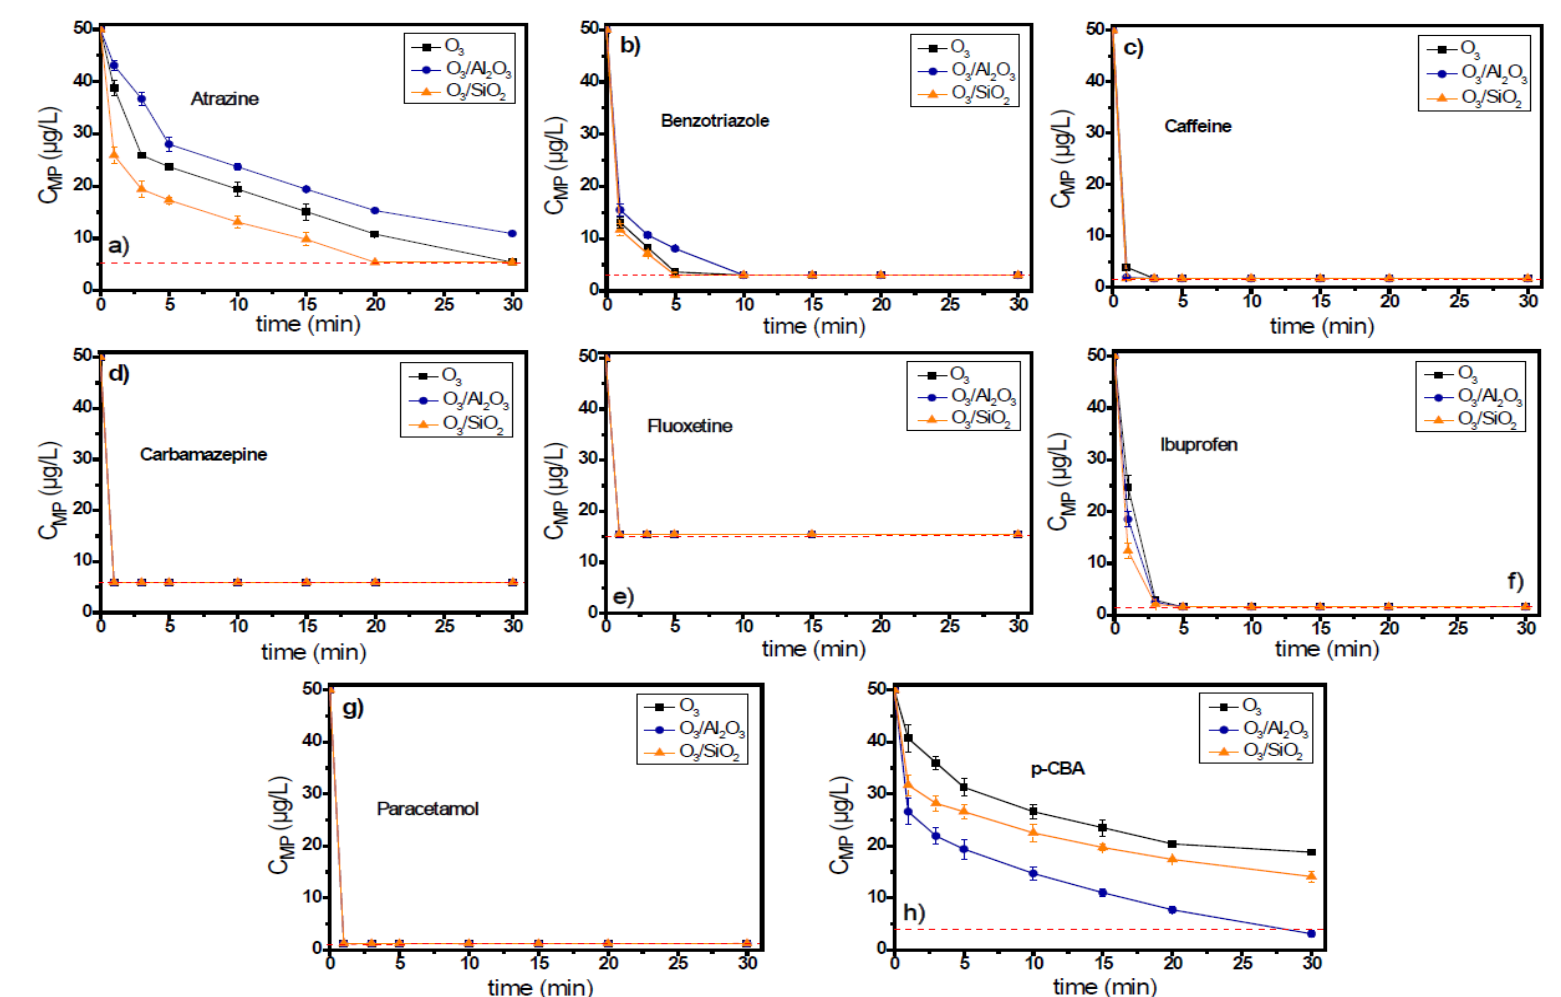
Figure 6. The degradation of ( a ) atrazine, ( b ) benzotriazole, ( c ) caffeine, ( d ) carbamazepine, ( e ) fluoxetine, ( f ) ibuprofen, ( g ) paracetamol, and ( h ) p-CBA in a mixed solution during the application of catalytic ozonation with the use of Al 2 O 3 or SiO 2 as potential catalysts compared to the application of single ozonation in natural potable water matrix. Experimental conditions: C MPs 50 μg/L, C catalyst 0.5 g/L, C O3 2 mg/L, pH 7.8, Temperature 23 ± 2 °C.